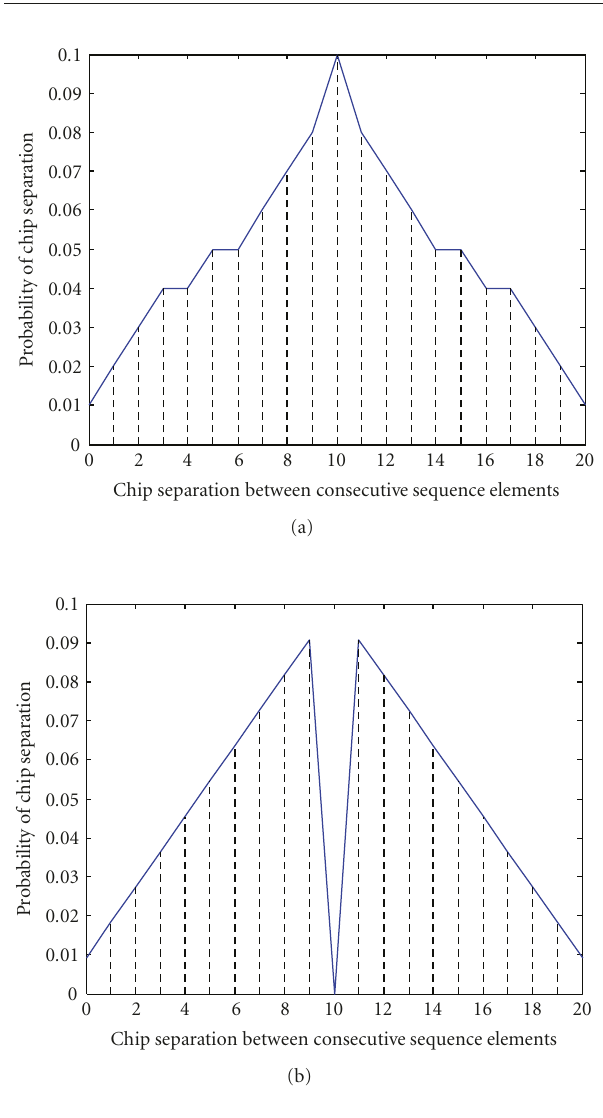
Figure 5: Chip separation probabilities for (a) Reed-Solomon and (b) linear congruence